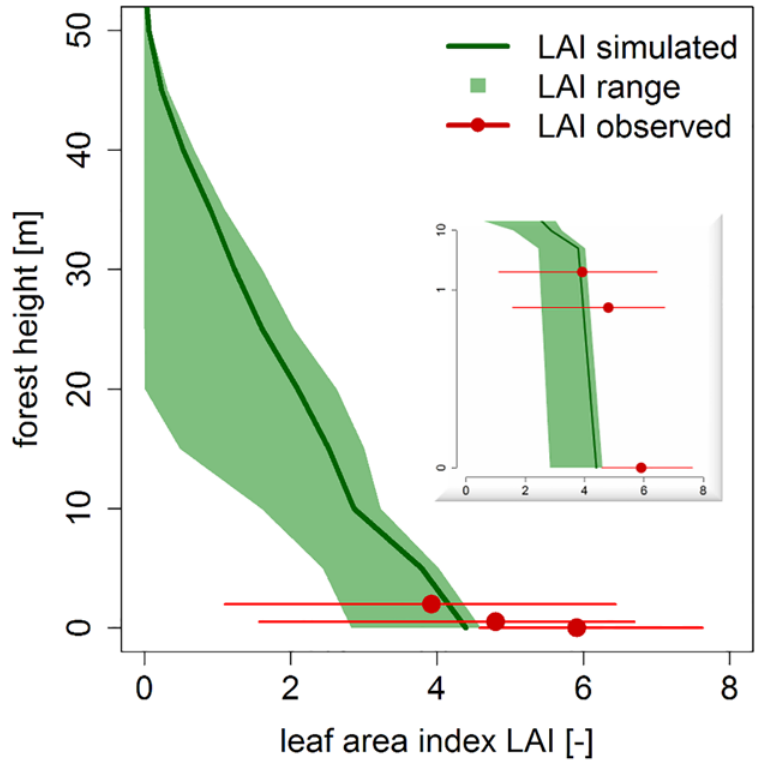
Fig 4. Leaf area index (LAI) for different height layers in a forest. The green line is the mean of the simulated LAI, the green area is the range of the LAI in different height layers. The red points are the mean measurements of the LAI in the investigated forest, the red lines are the measured